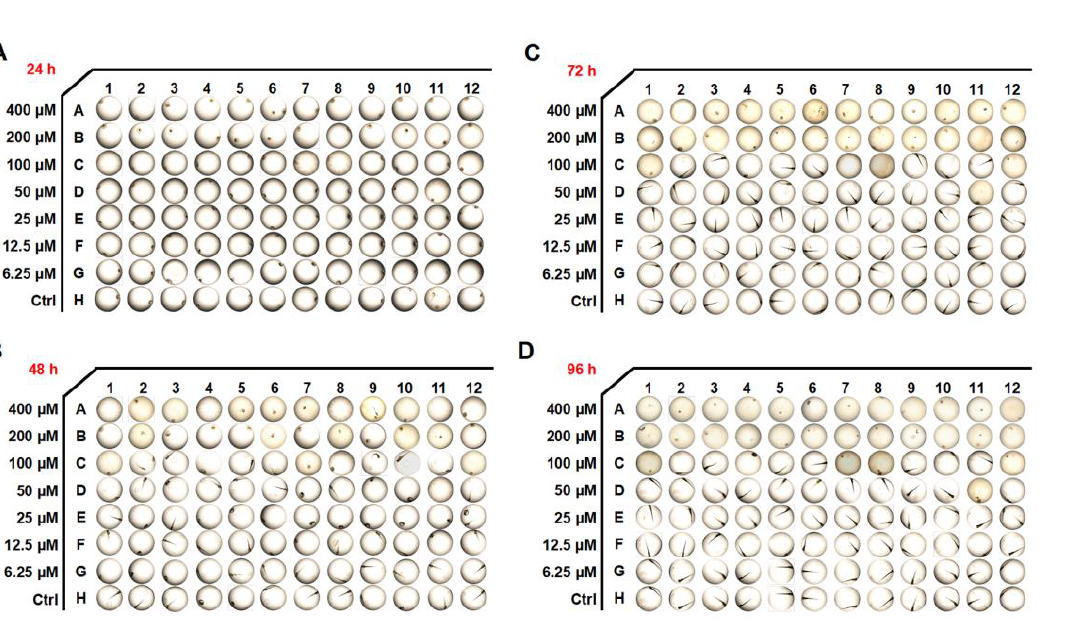
Figure 8. Developmental effects of 6-SH on embryos. ( A – D ) The embryo morphology after 6-SH treatment for 24 – 96 h ( n = 12).